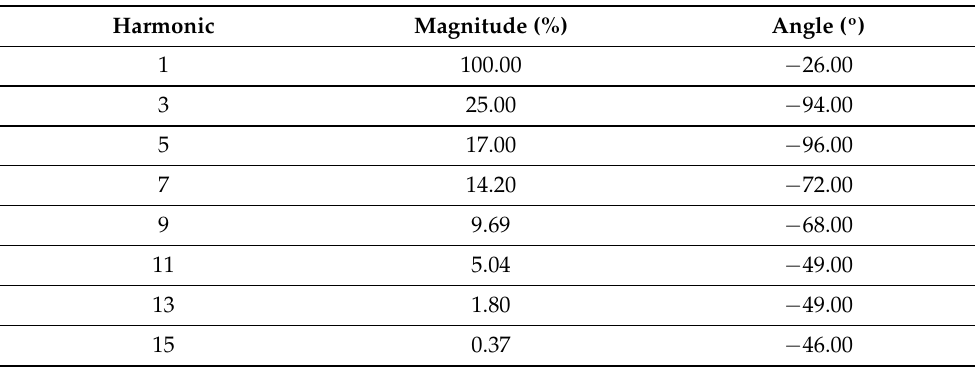
Table 4. Charger current harmonics [13].